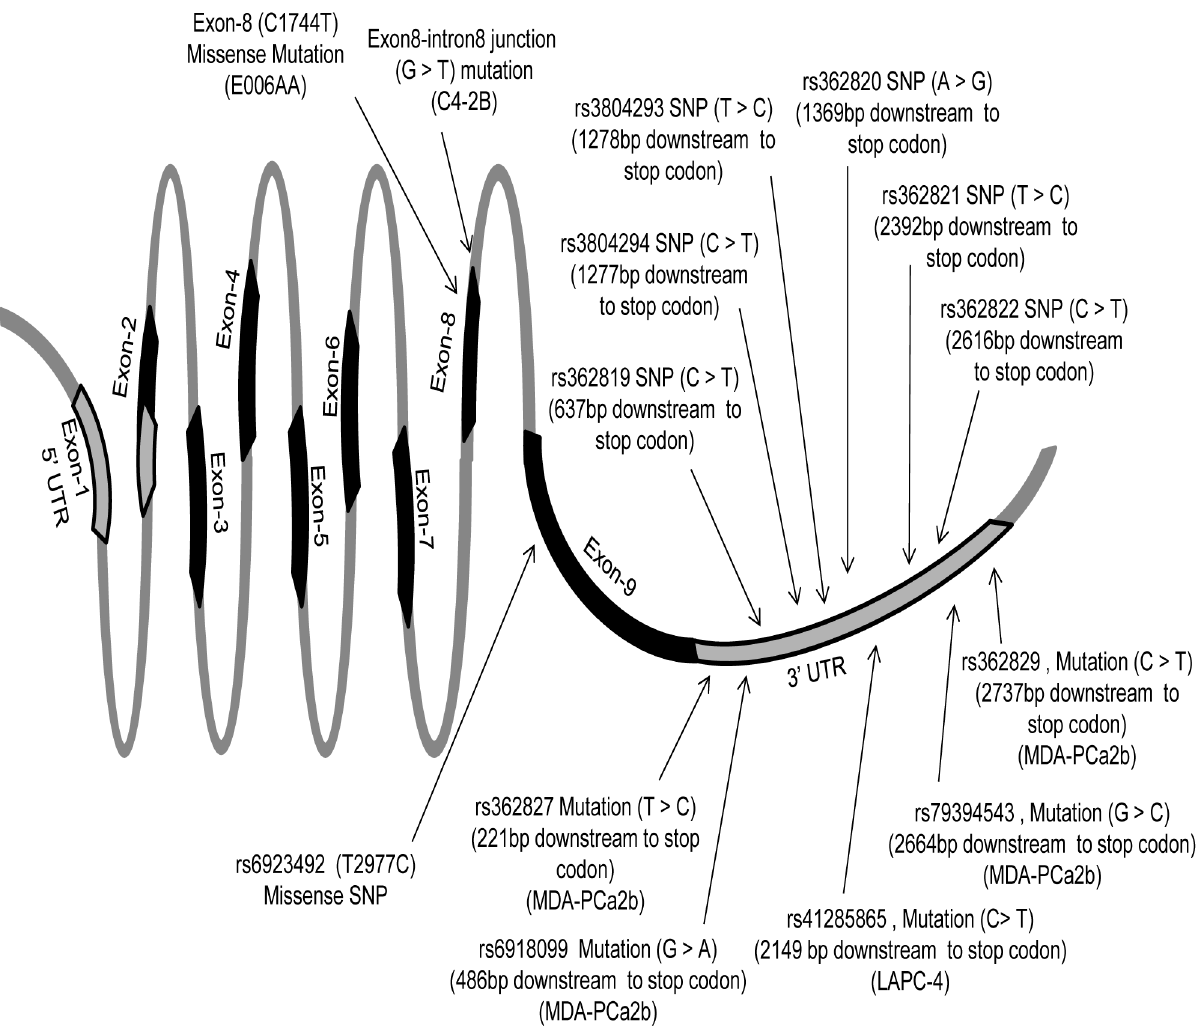
Figure 1. Schematic presentation of the identified mutations and polymorphisms of full-length GRM1 gene in prostate cancer cell lines and tissues.